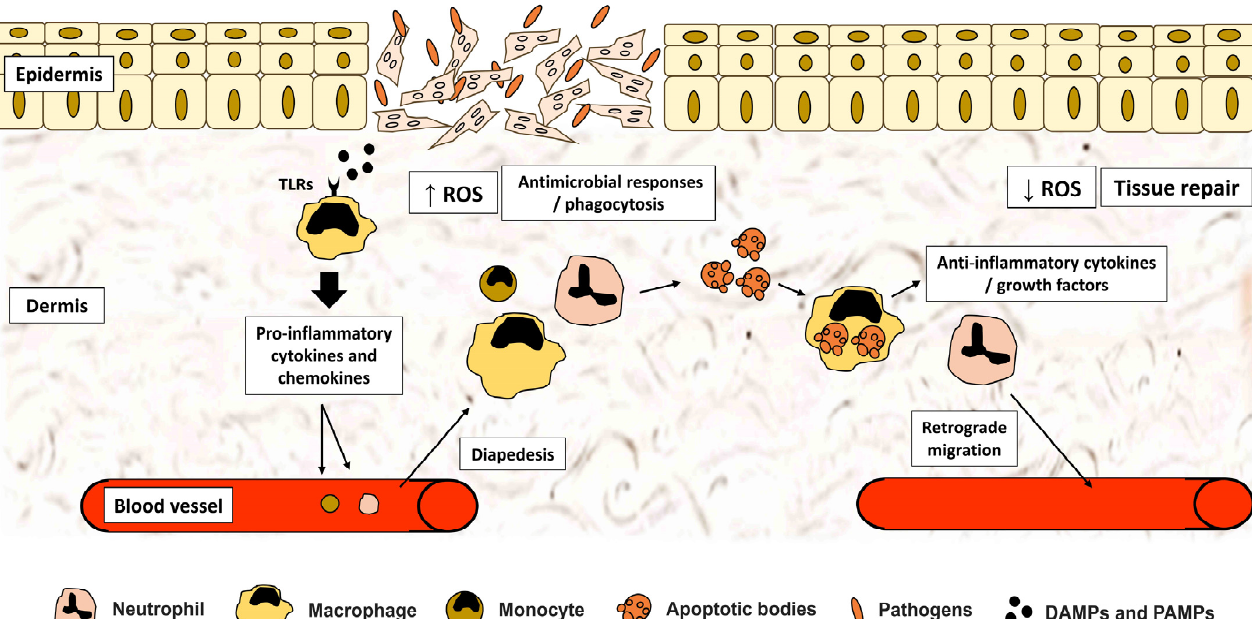
Figure 1. Induction and resolution of acute inflammation during tissue repair. Pathogen/Damage Associated Molecular Patterns (PAMPs/DAMPs) associated with an injury bind to Toll-like receptors (TLRs) expressed by tissue-resident cells, including macrophages. These cells release proinflammatory mediators and chemokines to activate an acute inflammatory program, recruiting leukocytes from nearby blood vessels. Neutrophils and monocytes gradually infiltrate the injury site to exert antimicrobial mechanisms, including increased reactive oxygen species (ROS) production. Following the eradication of pathogens, neutrophils undergo apoptosis to be engulfed by macrophages (efferocytosis). Activated macrophages endure polarization to release anti-inflammatory cytokines leading to resolution of inflammation and reduction in ROS levels. Moreover, a retrograde migra- tion of neutrophils aids in decreasing infiltrating leukocytes. Additionally, macrophages release various growth factors to trigger tissue repair machinery.